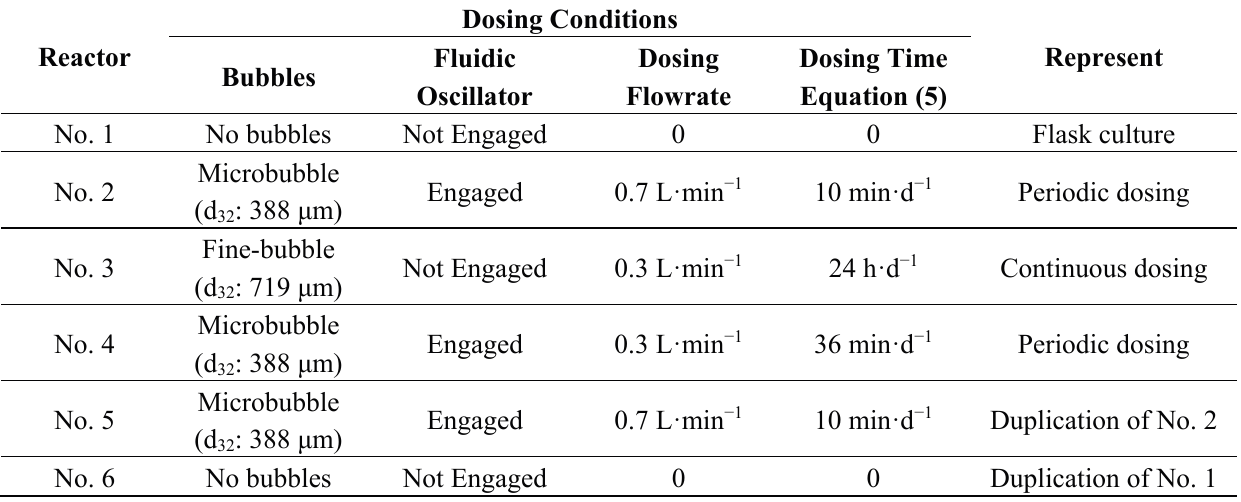
Table 4. The dosing conditions for each culture. The average size for the microbubbles and fine bubbles were measured by using high speed camera